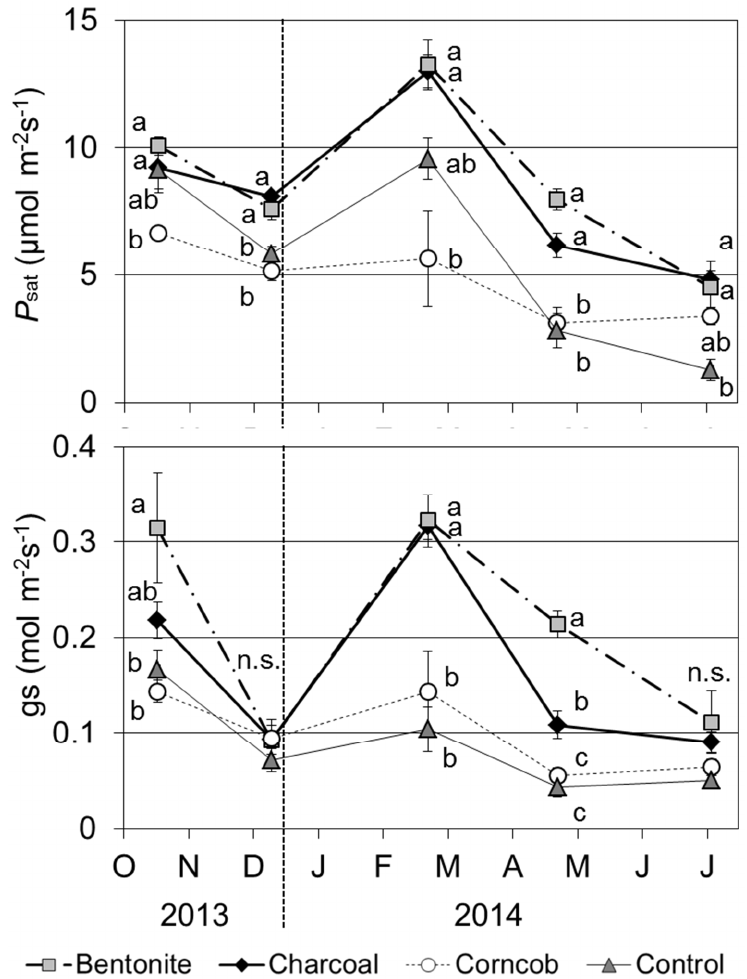
Figure 6. Photosynthetic rate at light saturation ( P sat ) and stomatal conductance (gs) for teak seedlings grown in the four treatments (9–11 a.m., Mean ± SE, n = 4).